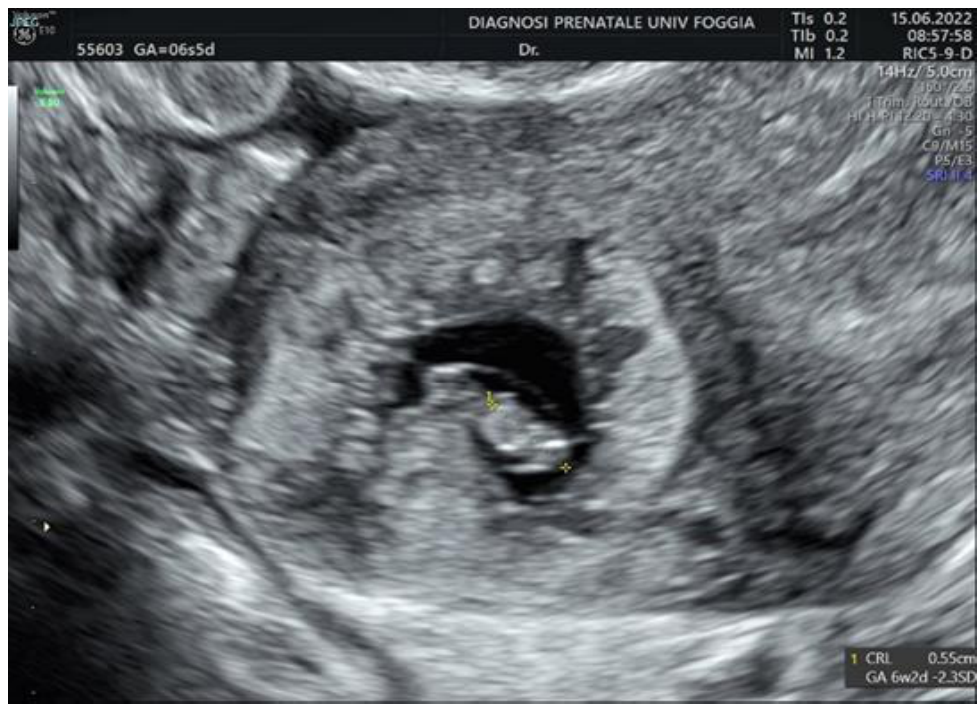
Figure 2. Embryo located eccentrically in the right side of the uterine fundus.